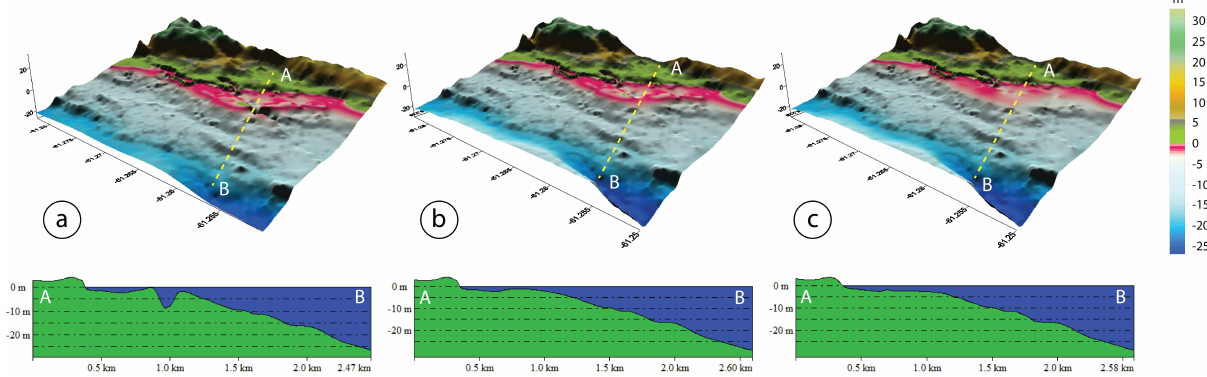
Fig. 5. The 3 different grids of St Franc¸ois: (a) normal bathymetry interpolated from existing data sets; (b) the same grid without a gap within the fringing reef; (c) the same grid without the fringing reef. A bathymetric profile underlines the characteristic of each